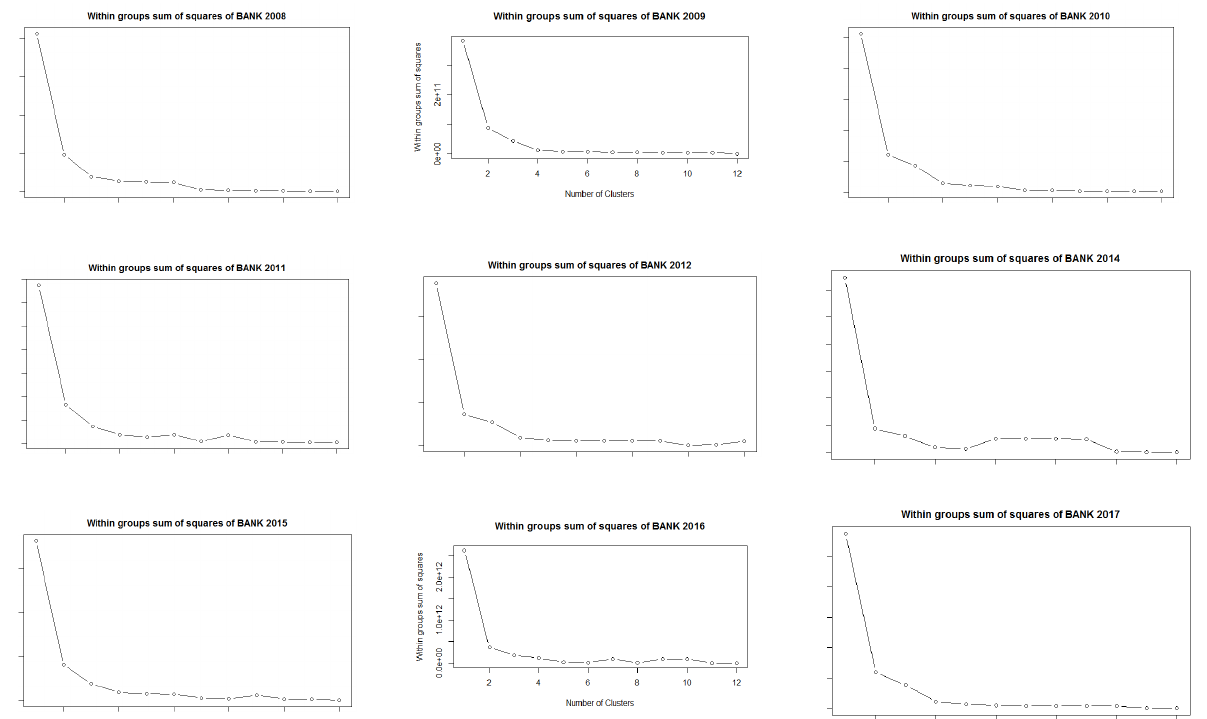
Figure A2. Within group sum of square value. Note: these figures show the within sum of square value in response to the number of clusters (2008–2017). Source: author’s